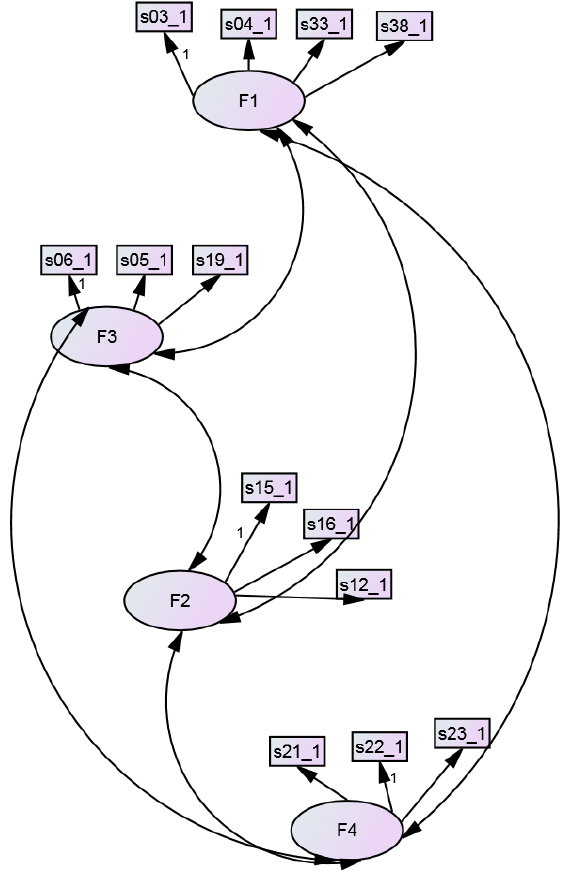
Figure 1. Resulting model in a Confirmatory Factor Analysis